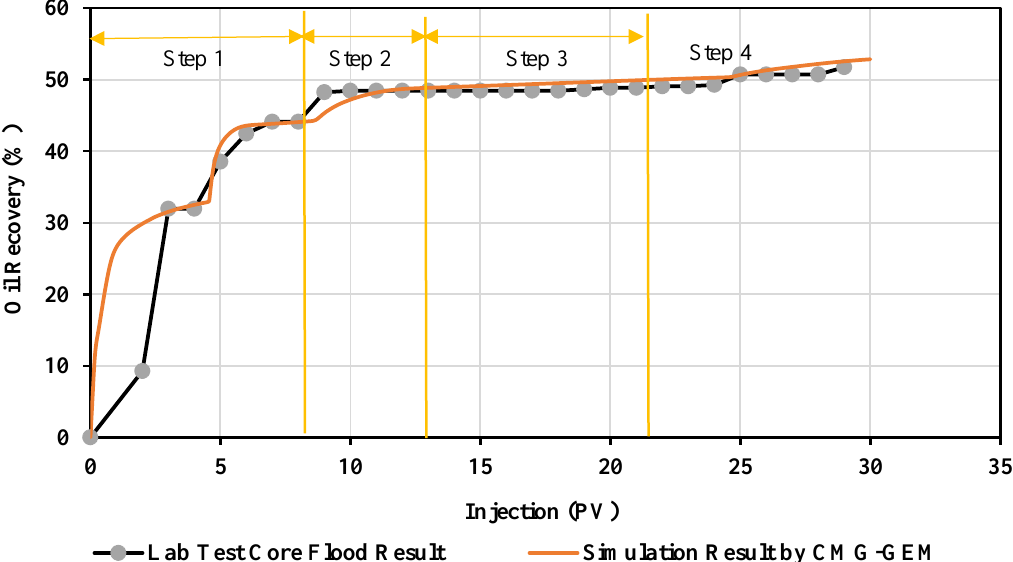
Figure 7. Laboratory and simulation results of different salinity water injections, step 1 is formation water with a salinity of 3%; step 2 with a salinity of 1%; step 3 with a salinity of 0.5%; and step 4 with a salinity of 0.1%.